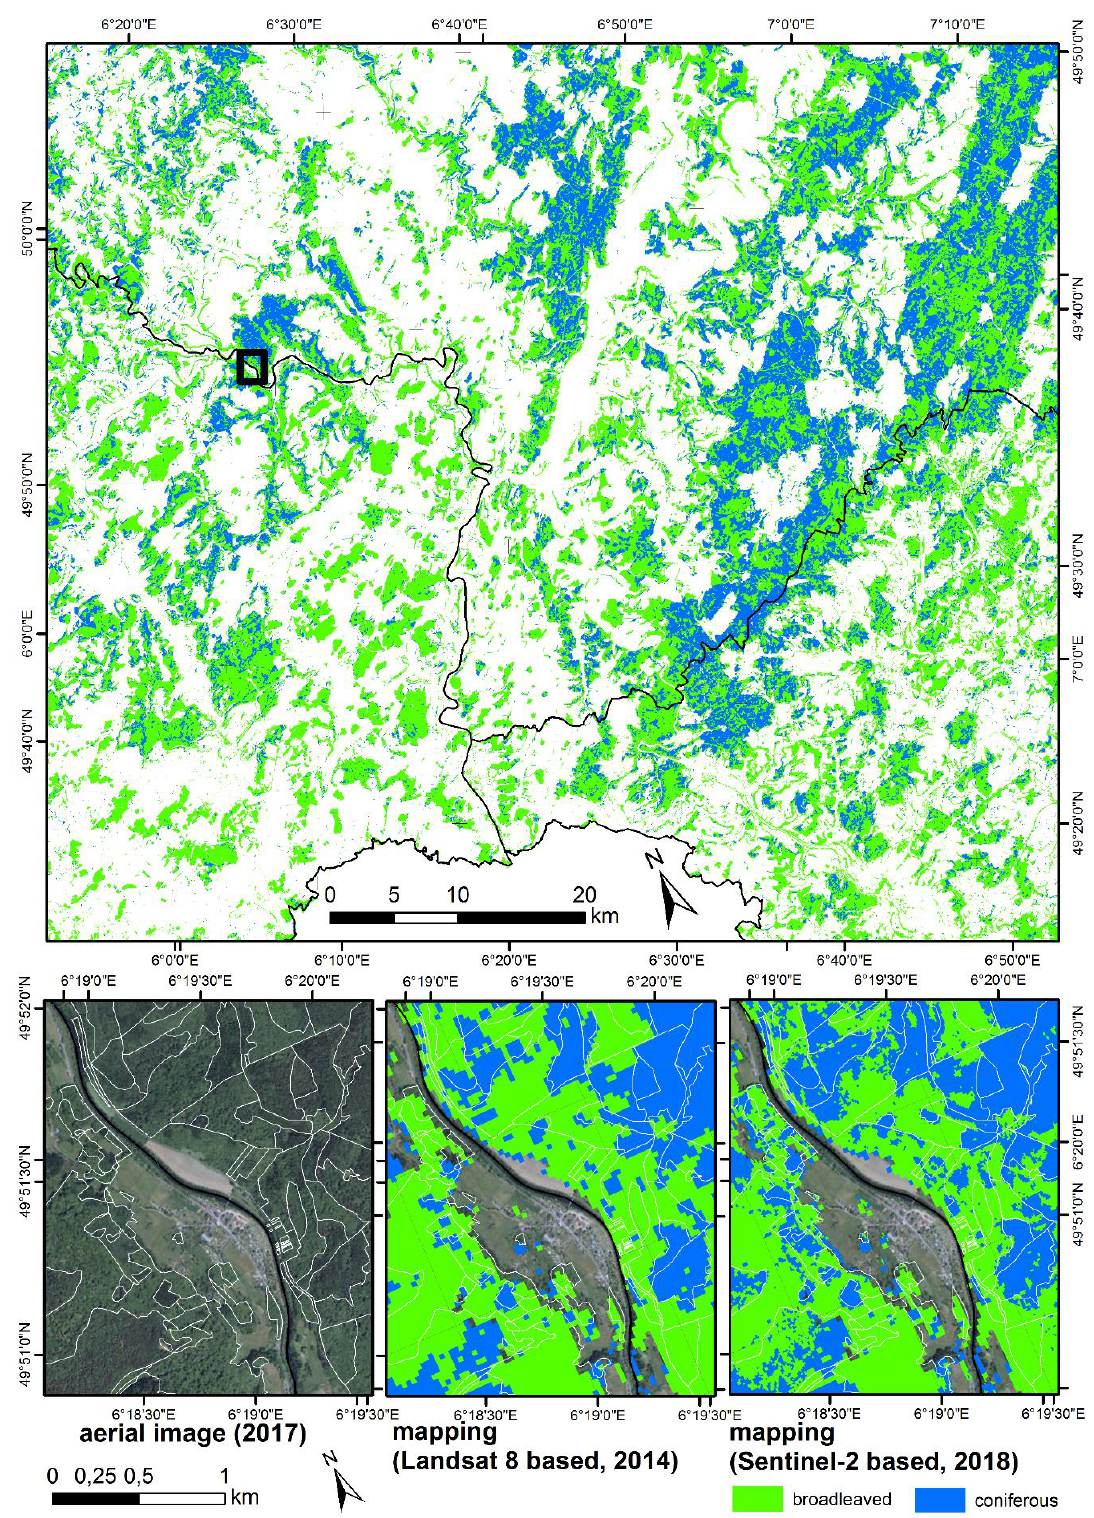
Figure7. Depictionofthespatiallyexplicitandconsistenttransnationalforesttypemappingintheborder Figure 7. Depiction of the spatially explicit and consistent transnational forest type mapping in the region Luxembourg / RLP and comparison of the mapping based on Landsat-8 and Sentinel-2 border region Luxembourg/RLP and comparison of the mapping based on Landsat-8 and Sentinel-2 imagery.